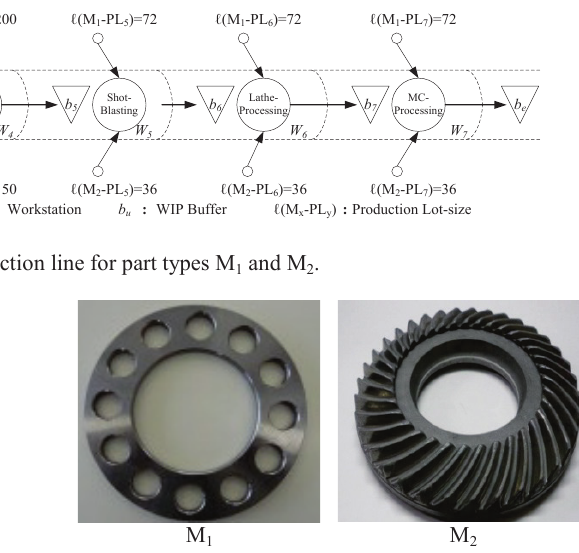
Fig.2. Relative statistical data on multiple part types from the current production.